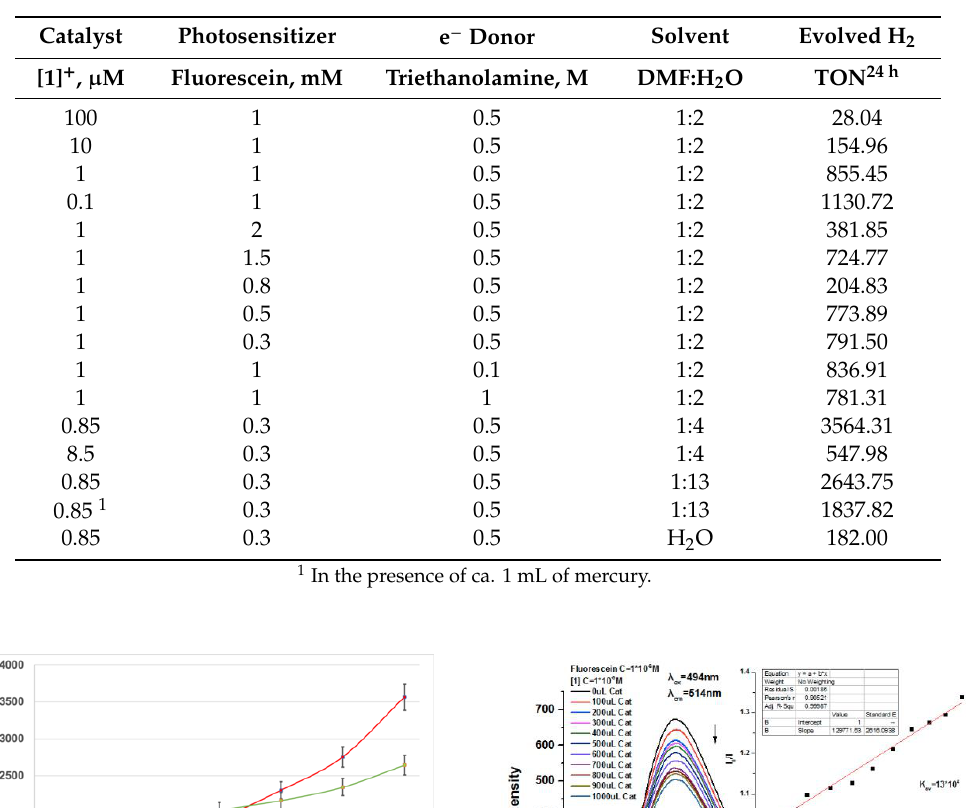
Table 1. Performance of the photocatalytic system under various conditions.